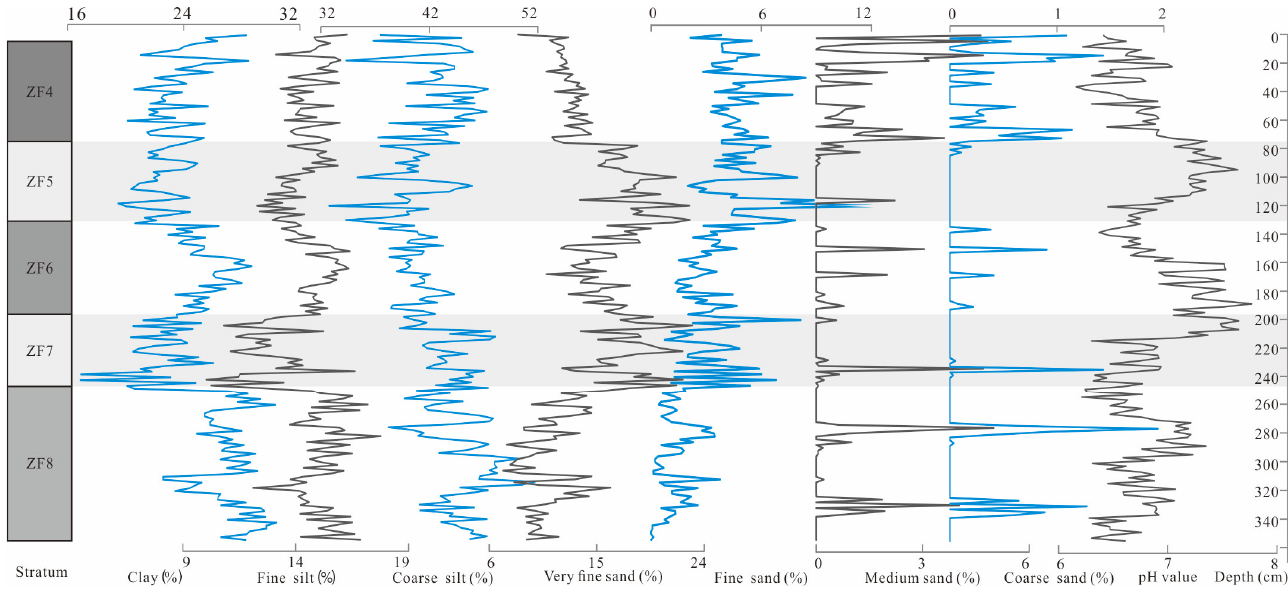
Figure 3. Grain size composition and pH of the ZFS during MIS 5 period.